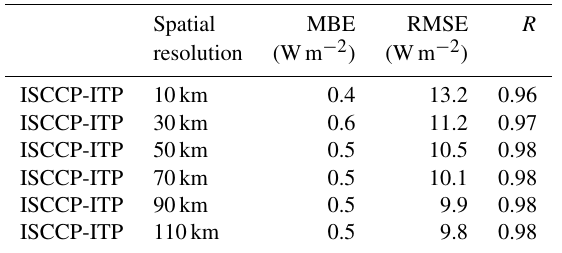
Table 3. Effect of spatial resolution (from 10 to 110km) on accu- racy of our estimated daily PAR product (ISCCP-ITP) compared to observations at the seven SURFRAD stations.